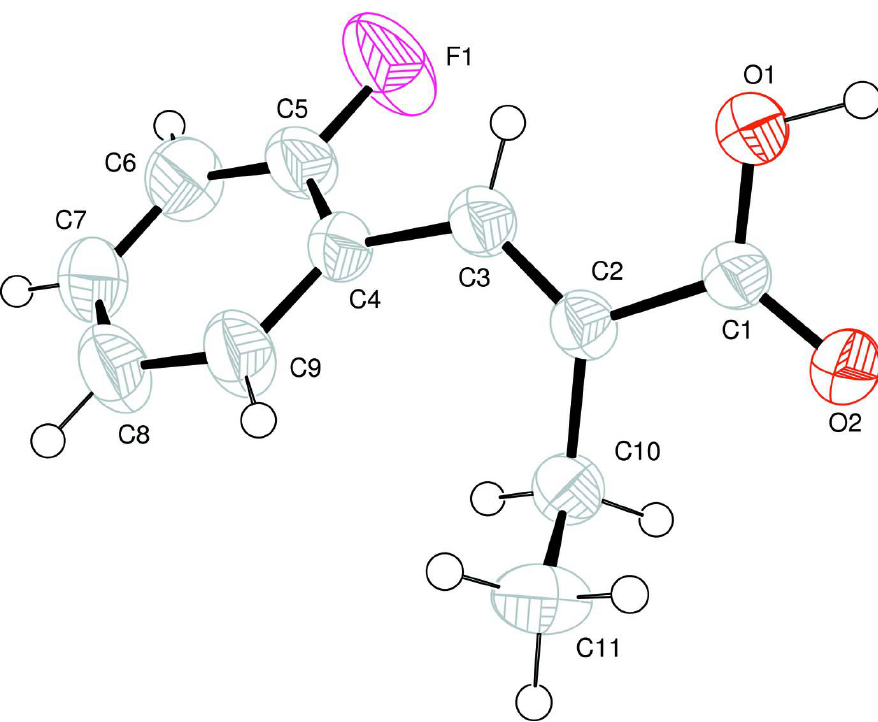
Figure 1 ORTEP drawing of the title compound, C the 50% probability level. H-atoms are shown by small circles of arbitrary radii.